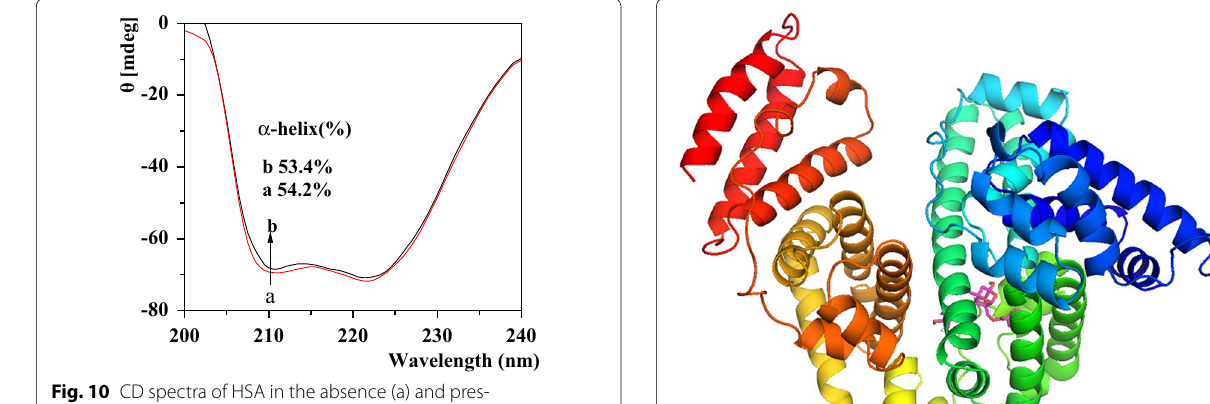
1.0 10 − 6 mol L − 1 , [paeoni‑ = ×